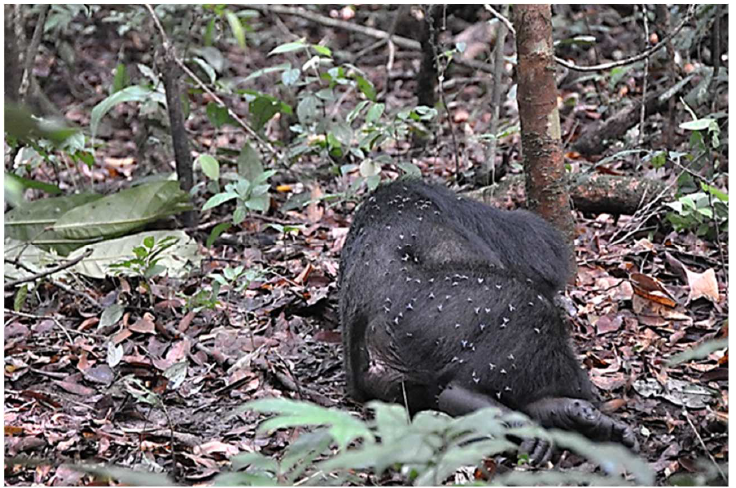
Figure 2. Flies attracted to a sleeping chimpanzee. Photo courtesy of Fabian Leendeertz and the Tai Chimpanzee